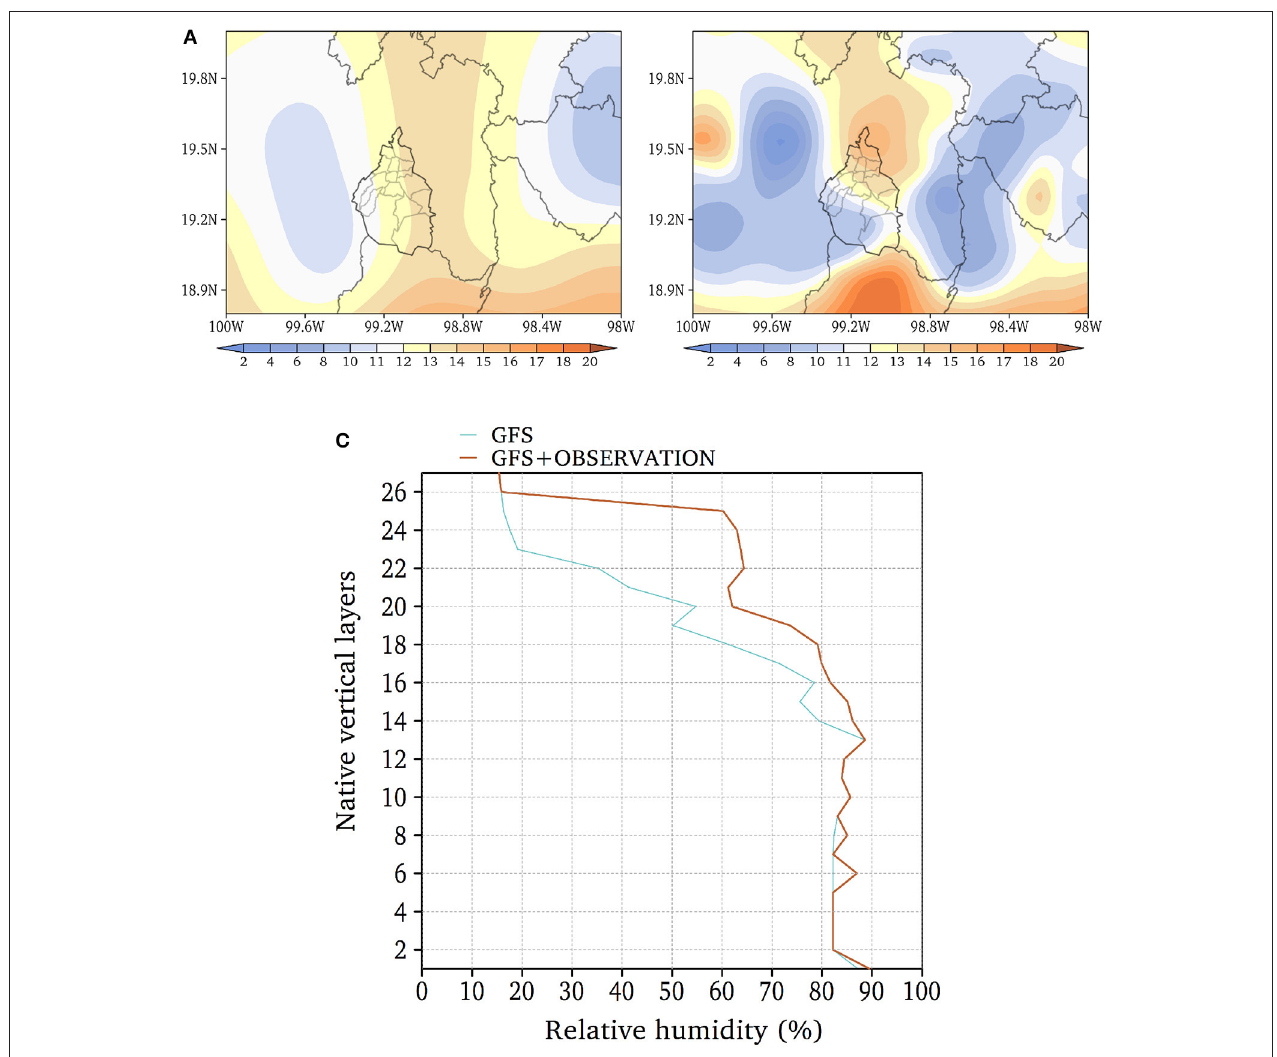
FIGURE 4 | Comparison of the 2m temperature field ( ◦ C) at 12:00 UTC 16 July 2014: (A) GFS model; (B) GFS model plus observations using Cressman objective analysis; and (C) the relative humidity profile (%) of the GFS model (blue line) and the GFS model plus radiosonde (brown